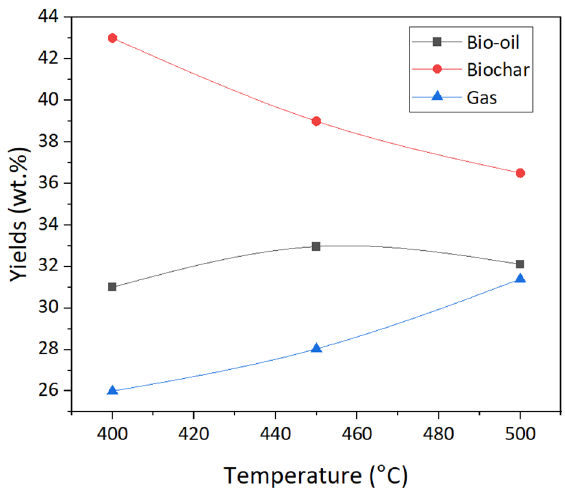
Figure 4. Effect of temperature on the product distributions of teff husk